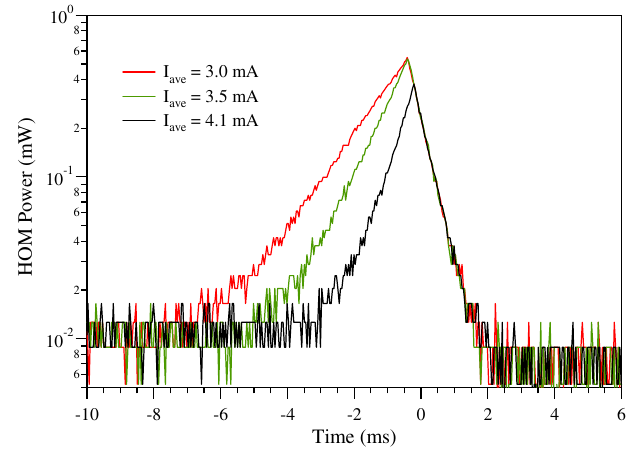
FIG. 8. (Color) A plot of the HOM power of the 2106 MHz mode as a function of time for three different values of macro- pulse current (note the logarithmic scale of the vertical axis).